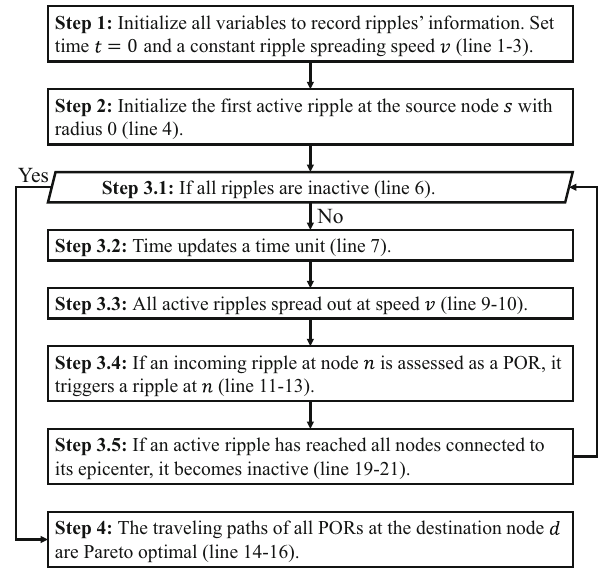
Fig. 5 The flowchart of the RSA using the metaphor-based language